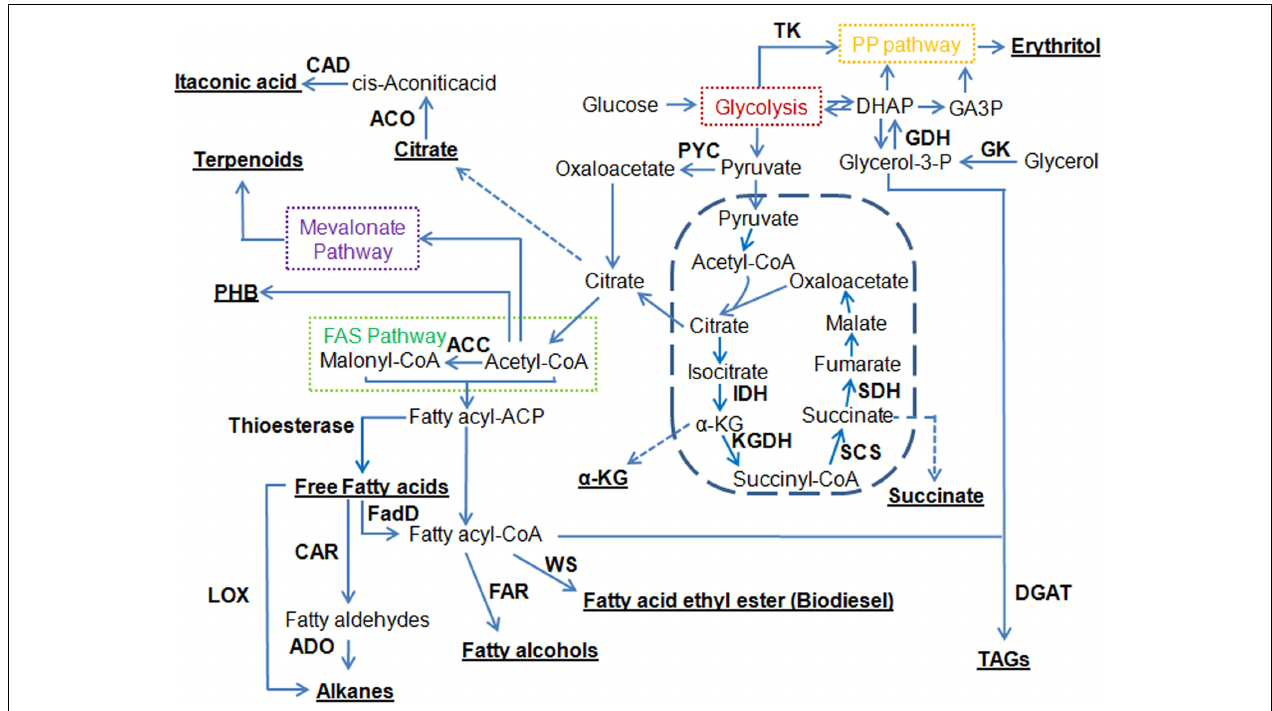
FIGURE 1 | Overview of metabolic pathways for engineering oleaginous yeasts to produce a variety of different compounds. Underlined are target compounds produced by oleaginous yeasts. ACC, acetyl-CoA carboxylase; ACO, aconitase; ADO, aldehyde deformylating oxygenase; CAD, cis -aconitic acid decarboxylase; CAR, carboxylic acid reductase; DGAT, diacylglycerol acyltransferase; DHAP, dihydroxyacetone phosphate; FadD, fatty acyl-CoA synthetase; FAR, fatty acyl-CoA reductase; FAS pathway, fatty acid synthase pathway; GA3P, glyceraldehyde-3-phosphate; GDH, glycerol-3P dehydrogenase; GK, glycerol kinase; IDH, isocitrate dehydrogenase; α -KG, α -ketoglutarate; KGDH, ketoglutarate dehydrogenase; LOX, lipoxygenase; PHB, poly-3-hydroxybutyrate; PP pathway, pentose phosphate pathway; PYC, pyruvate carboxylase; SCS, succinyl-CoA synthase; SDH, succinate dehydrogenase; TAGs, triacylglycerols; TK, transketolase; WS, wax ester